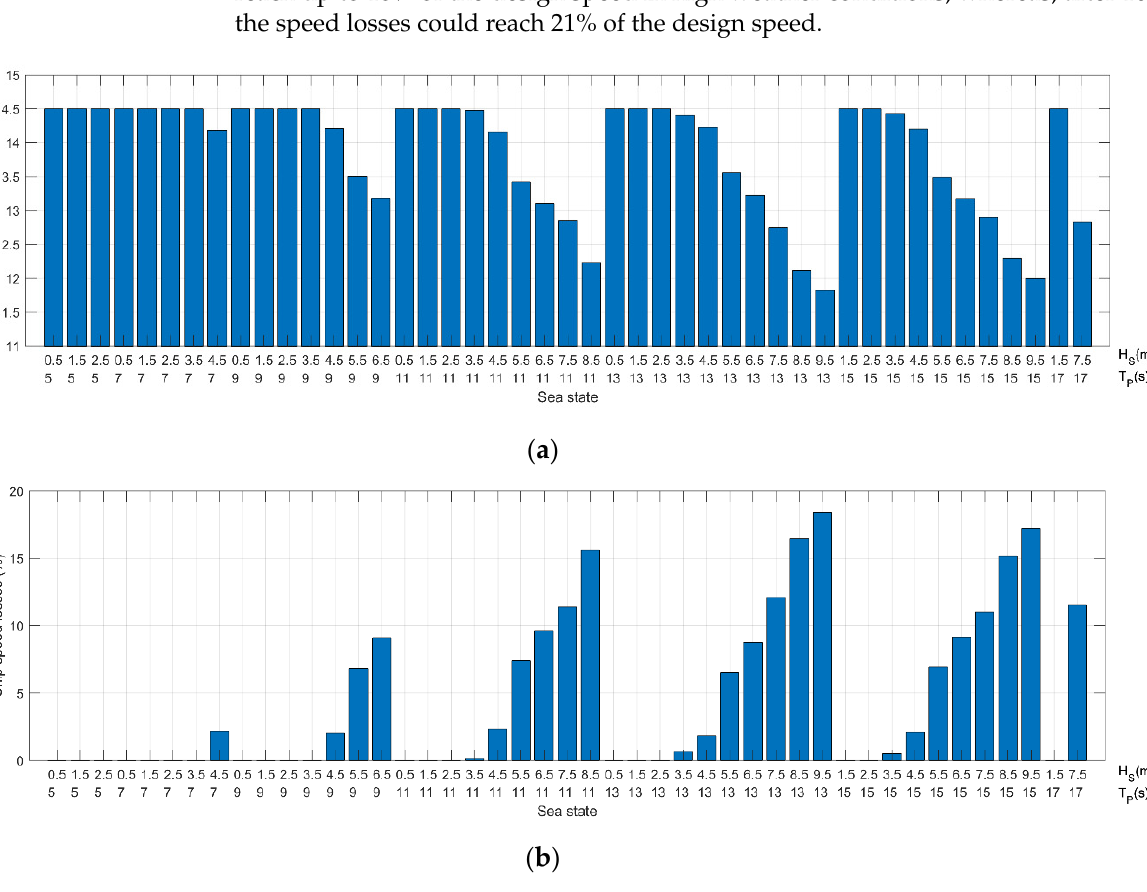
Figure 9. Variation of ship speed ( a ) and percentage of speed losses ( b ) for different sea states for new ship.